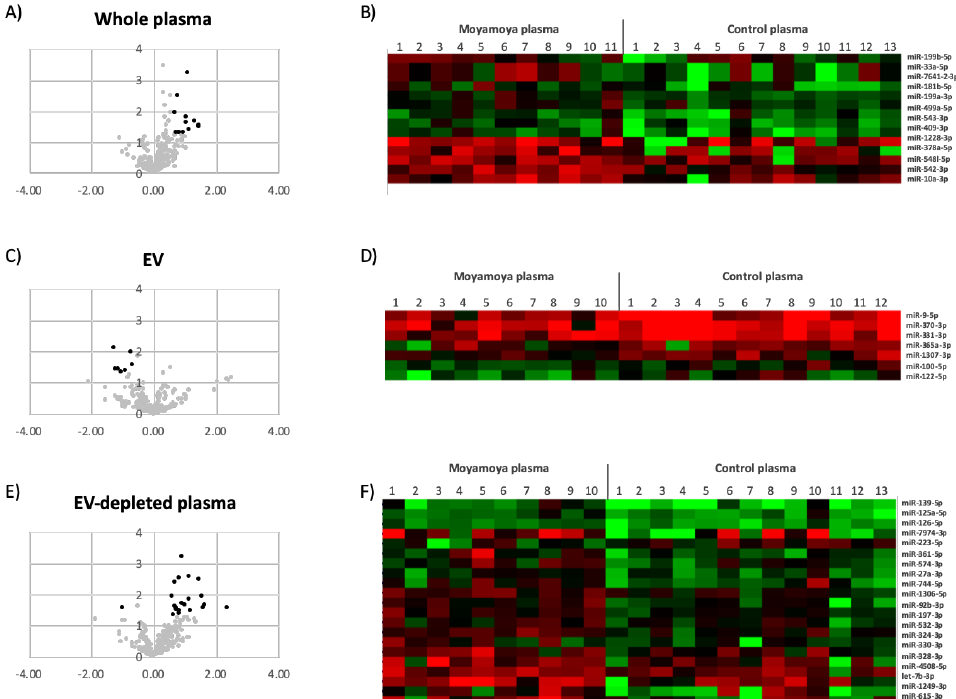
Figure 1. Circulating miRNAs affected by moyamoya. The volcano plots show the effects of moyamoya on circulating miRNA in whole plasma ( A ), EVs ( C ) and EV-depleted plasma ( E ). The black dots in the volcano plots depict that miRNAs were significantly affected. The heat maps are the mean-centered expression profiles of affected miRNAs in whole plasma ( B ), EVs ( D ) and EV-depleted plasma ( F ). The patient conditions are indicated on top of the figures. The colors represent the miRNA concentrations that are either higher (red) or lower (green) than the average concentration of specific miRNA across all the samples.